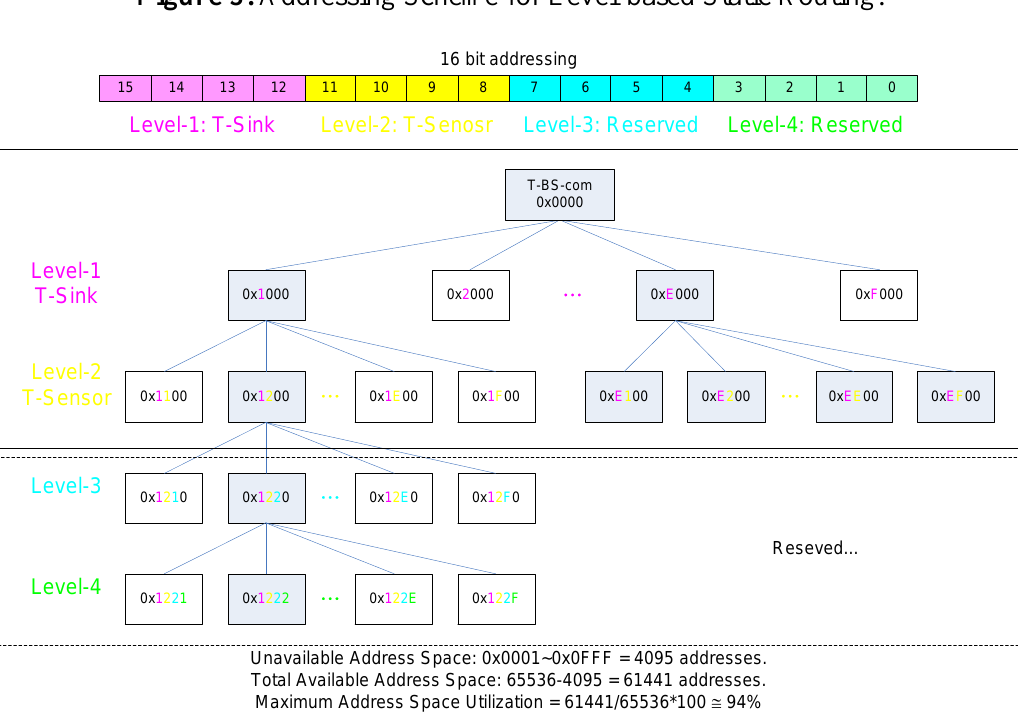
Figure 3. Addressing Scheme for Level-based Static